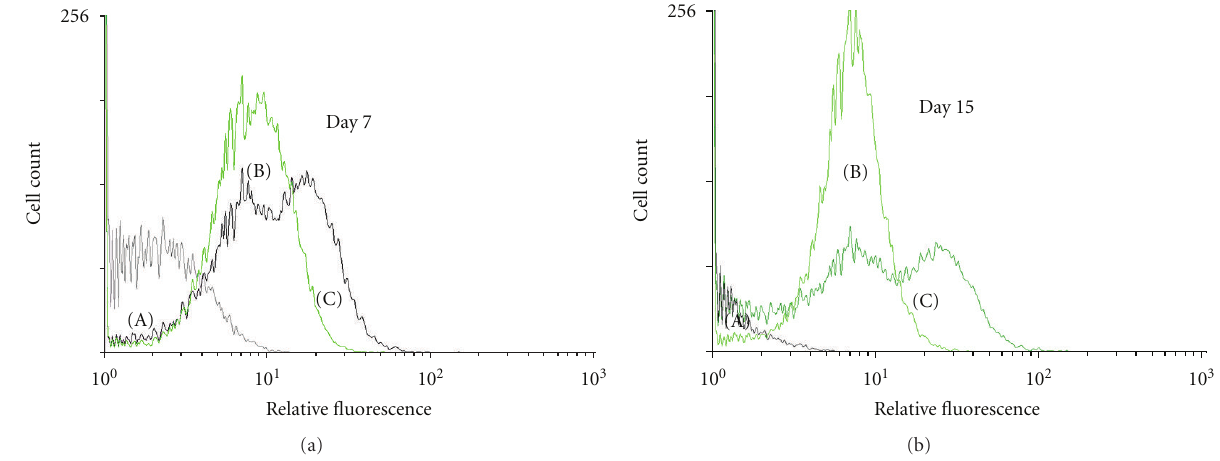
Figure 2: FACS analysis of GFP expression in nontransfected and transfected cNPCs. FACS analysis was performed on nontransfected and transfected cNPCs to show the expression of the GFP reporter gene. The vertical axis shows cell count, and the horizontal axis shows relative fluorescence. (a) Nontransfected cNPCp25 cultured in UM; (b) transfected cNPCp25 cultured in UM; (c) transfected cNPCp25 cultured in UM containing 10% FBS for 7 days (a) and 15 days